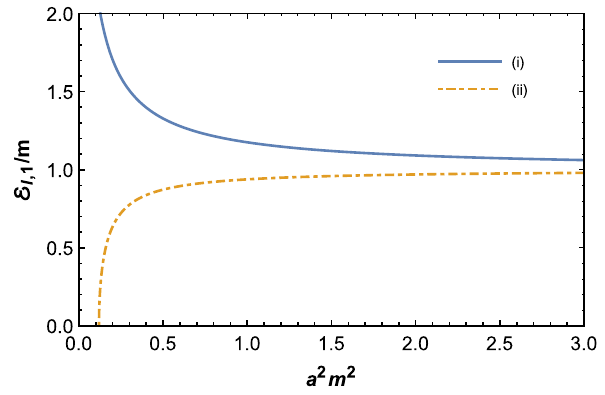
(cid:12) (cid:12) (cid:12) (cid:12) (cid:12) E l , 1 (cid:12) when the signal inside the square root is m